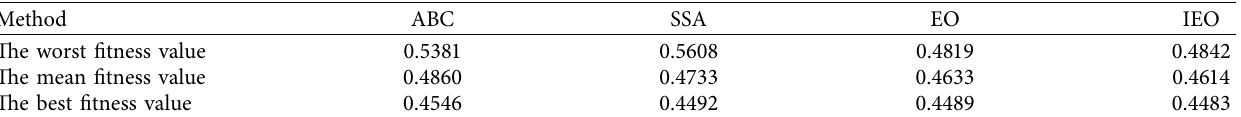
Table 7: Te comparison of ftness values found by four implemented methods for the IEEE 85-bus system.